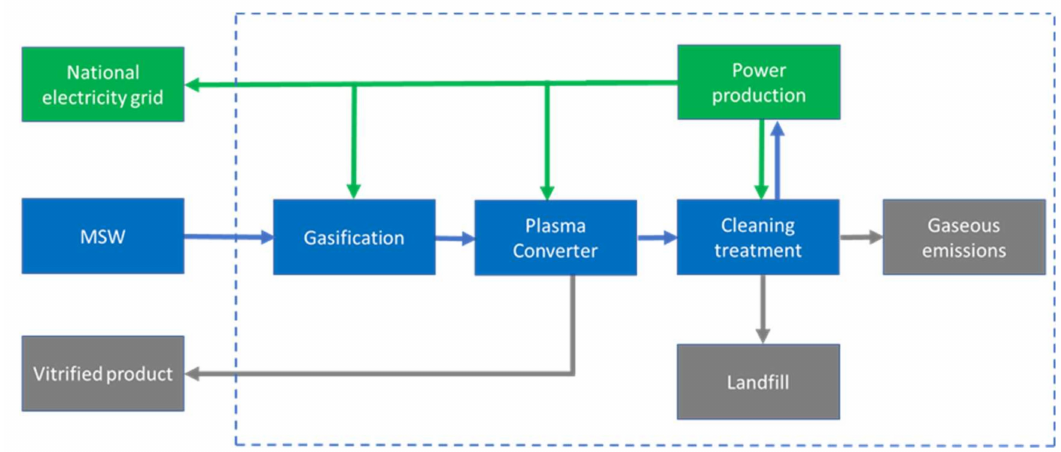
Figure 1. System limits within the plasma gasification assessed in this study.